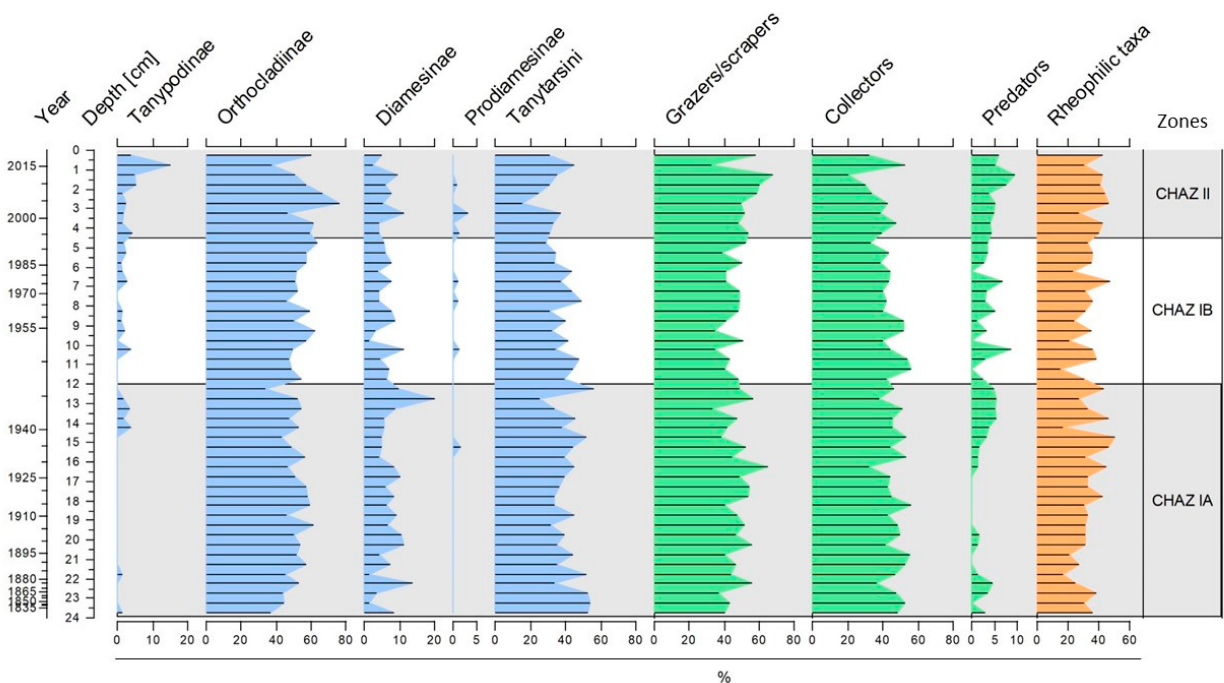
Figure 4. Subfamilies and ecological groups of the chironomid fauna based on feeding habits and relationship to flow. Colours denote: ■ subfamilies, ■ food strategy, ■ rheophilic